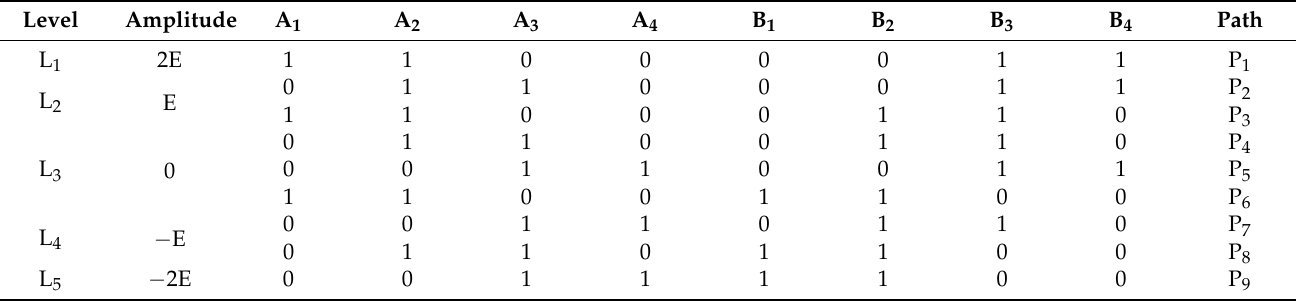
Table 7. Switching states under healthy